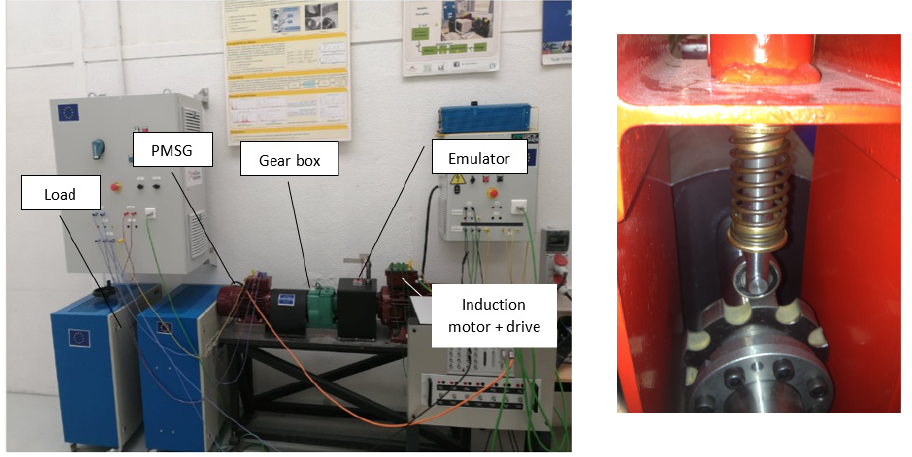
Figure 6. Test bench and fault